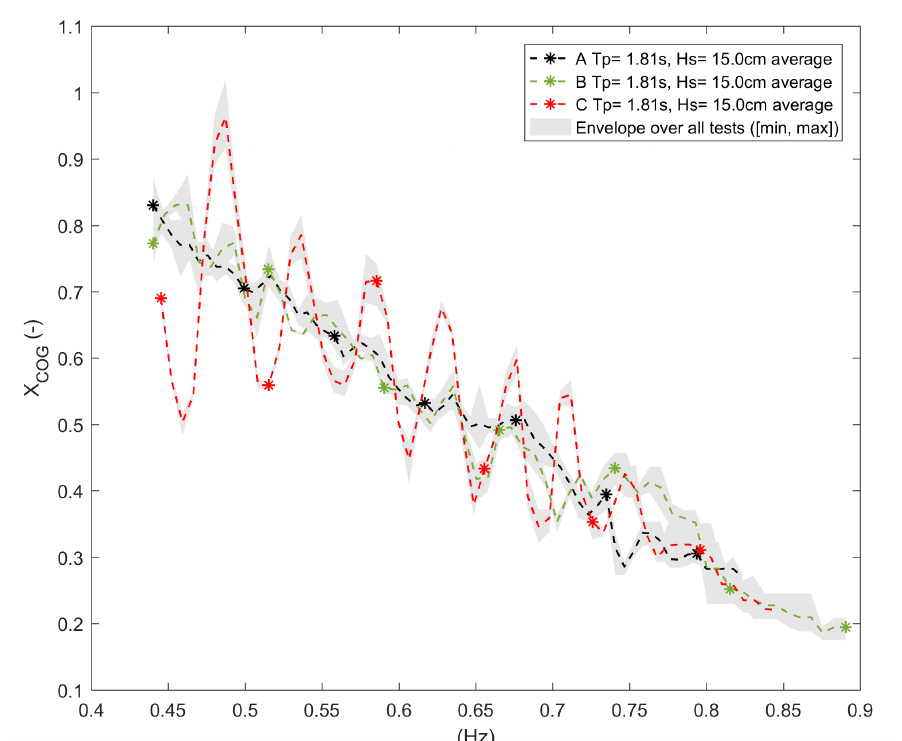
Figure 12. Surge RAOs for all JONSWAP T p = 1.81 s H s = 15 cm waves with distinct seeds.